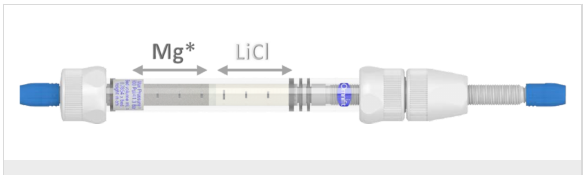
Figure 5: Stratified bicomponent column (Diba Omnifit EZ Solvent Plus) composed of magnesium (chips/powder, 1:1) and lithium chlo- ride separated with fiberglass for the turbo Grignard reagent synthesis.